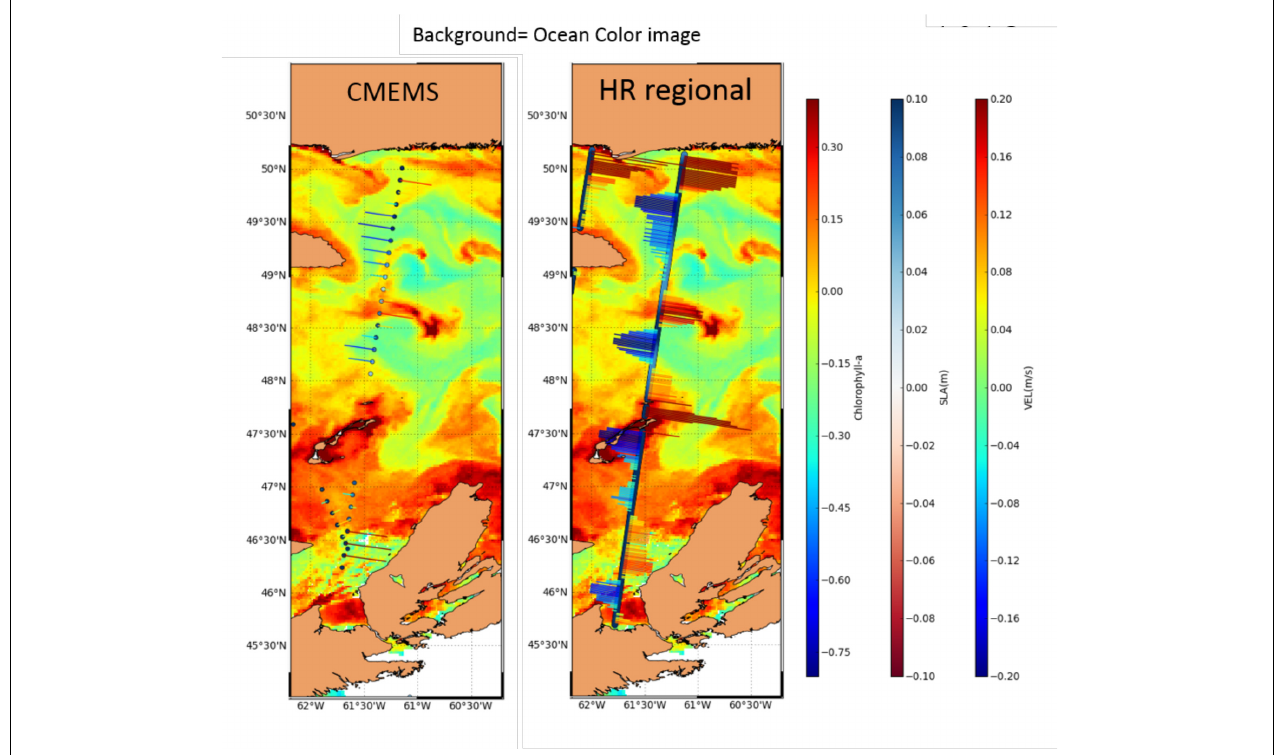
FIGURE 13 | Stick-plot of across-track geostrophic velocities in the Gulf of St Lawrence (Canada) computed from altimeter SLA of the CMEMS global altimetry dataset (Left) and of a regional high-resolution altimetry dataset (Right) . The background image deals with a high-resolution chlorophyll- a field produced by CLS processing chains for the same date on September 8, 2014. Copyright “Fisheries and Oceans Canada” and “Collecte Localisation